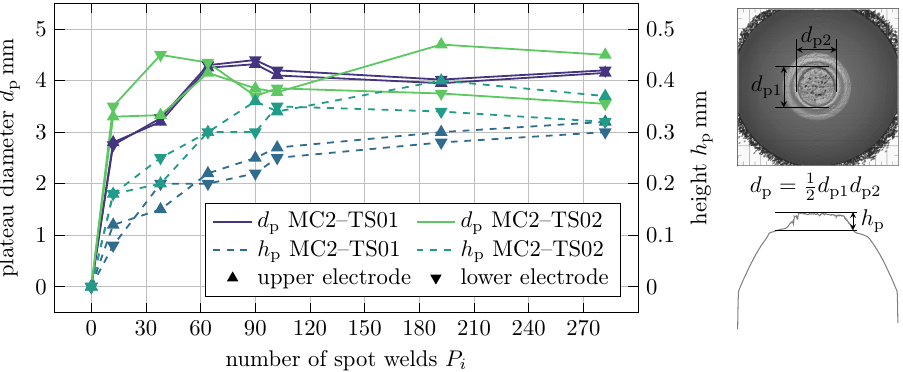
Figure 16. Plateau-forming development over number of spot welds due to axial material